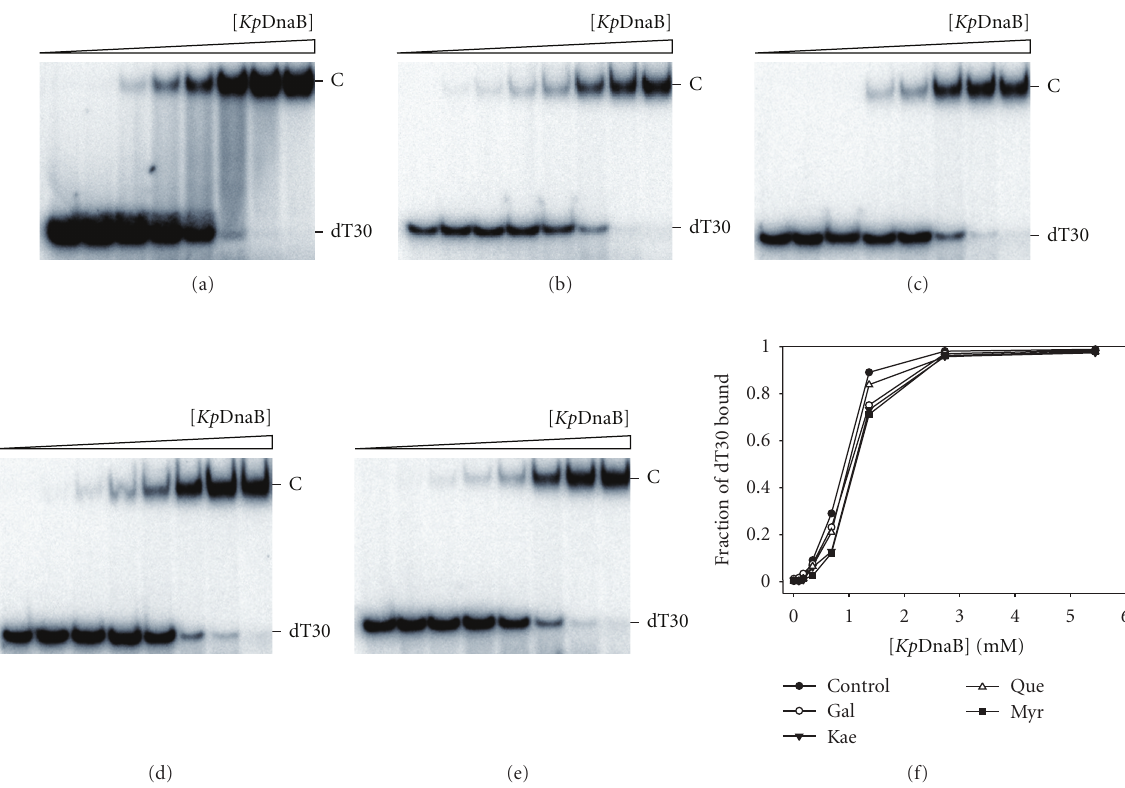
Figure 5: Inhibitory e ff ects of flavonols on ssDNA binding of Kp DnaB. EMSA of Kp DnaB bound to dT30 (a) in the absence of any flavonol or presence of (b) Gal, (c) Kae, (d) Que, or (e) Myr. (f) The titration curves for ssDNA binding of Kp DnaB. The apparent dissociation constant ( K d,app ) values of Kp DnaB bound to dT30 in the absence of any flavonol or presence of Myr, Que, Kae, or Gal, as determined from the titration curves, were 0.97 ± 0.07, 1.11 ± 0.05, 1.03 ± 0.07, 1.10 ± 0.05, and 1.03 ± 0.06 μ M,